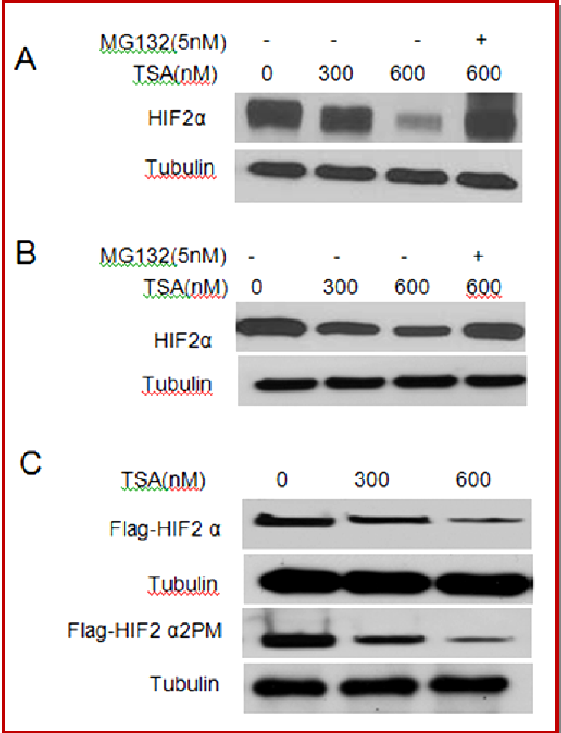
Figure 2: TSA-induced HIF-2 α degradation is proteasome de- pendent but VHL-independent (A) MG-63 cells were treated in hypoxia (1% O 2 ) for 8 hours in the pres- ence of TSA at 300 or 600 nM without or with 5 μ M proteasome inhibi- tor MG132. Cell extracts were subjected to western blot assay for HIF-2 α and tubulin. (B) VHL deficient (-/-) 786-0 cells were treated with TSA at different concentrations without or with 5 μ M proteasome inhibitor MG132 in normoxia for 8 hours. Cell extracts were subjected to western blot assay for HIF-2 α and tubulin. (C) 5 μ g of flag-tagged wild type HIF -2 α plasmid or prolyl residues 405 and 531 mutant (HIF-2 α 2PM) were transfected into MG-63 cells at 80% cell confluence with Lipofectamine 2000. One day later, cells were evenly split into 3 plates and exposed to hypoxia (1%O 2 ) for 8 hours with TSA at different concentrations, and cells extracts were subjected to immunoblotting with anti-flag and anti- tubulin antibodies